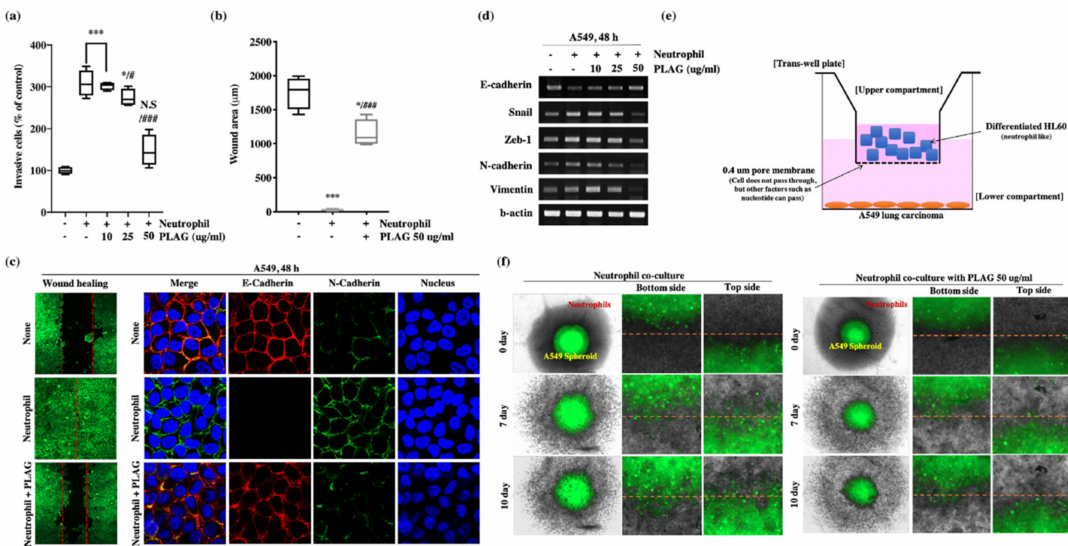
Figure 4. Inhibitory e ff ect of PLAG on metastasis in the tumor-infiltrating neutrophil microenvironment: ( a ) PLAG inhibited the invasive activity of A549 cells in the presence neutrophil. Compared with negative controls: * p < 0.05, *** p < 0.001. N.S., not significant. Compared with positive controls: